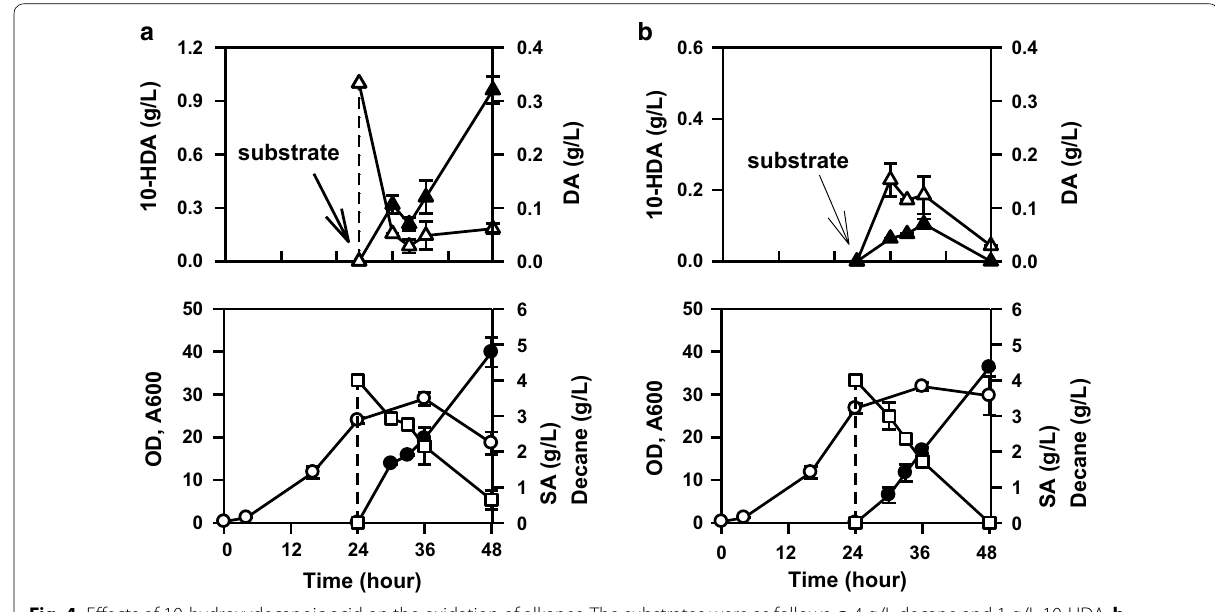
Fig. 4 Effects of 10-hydroxydecanoic acid on the oxidation of alkanes. The substrates were as follows: a 4 g/L decane and 1 g/L 10-HDA; b 4 g/L decane. Error bars represent standard deviation of two independent runs.